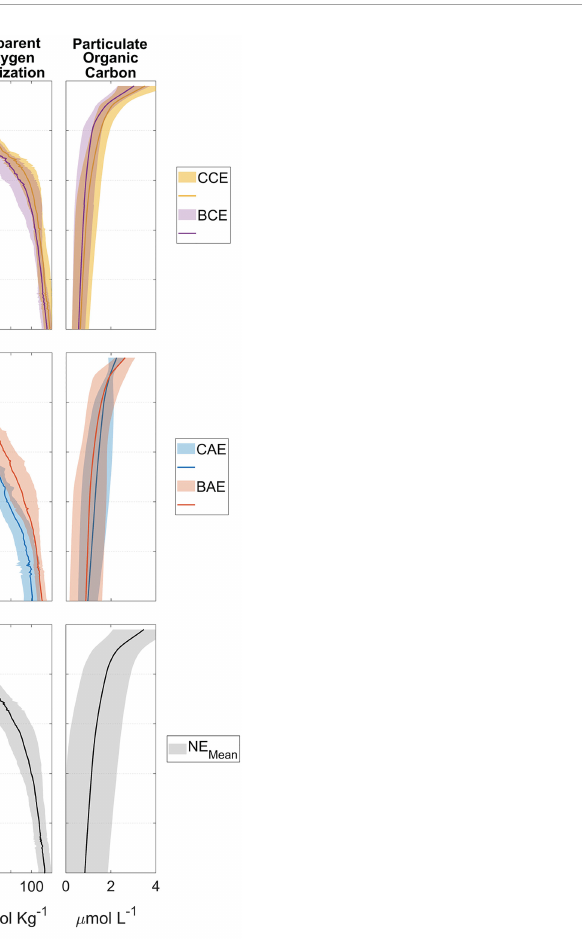
FIGURE 7 Mean and standard deviation pro fi les of density, fl uorescence, apparent oxygen utilization and particulate organic carbon for stations that fell near the center of a cyclonic eddy (CCE - yellow, A , top panel), near the border of a cyclonic eddy (BCE - purple, A , top panel), near the center of an anticyclonic eddy (CAE - blue, B , middle panel), near the border of an anticyclonic eddy (BAE - B , orange, middle panel) and the stations free of eddy in fl uence (NE - black, C , bottom panel) during the 2015, 2016 and 2017 GoM cruises.